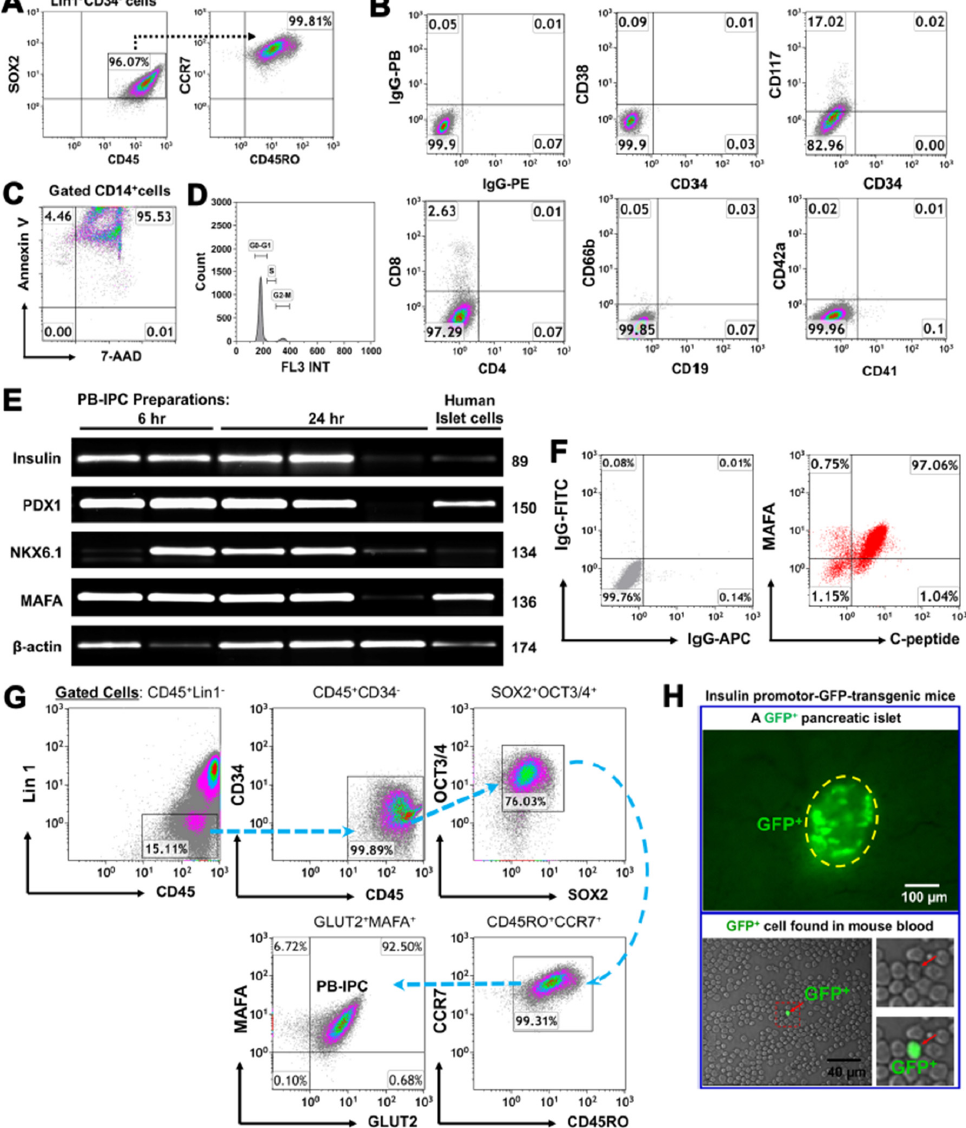
Figure 1. Characterization of peripheral blood-derived insulin-producing cells (PB-IPC) from adult peripheral blood with islet β -cell-related markers. ( A ) Characterization of PB-IPC. Peripheral blood-derived mononuclear cells (PBMC) were plated in Petri dishes in the presence of serum-free culture medium. After attachment overnight (12 hrs), PB-IPC were isolated by removing all floating cells and debris. The gated Lin1 - CD34 - cells express CD45, SOX2, CD45RO, and CCR7. Representative data from eight preparations. ( B ) Phenotype of PB-IPC, with low expression of CD117, but no expression of CD4, CD8, CD19, CD34, CD38, CD41, CD42a, and CD66b. Isotype-matched IgGs served as controls ( n = 8). ( C ) Apoptosis (Annexin V + ) and necrosis (7-AAD + ) of blood monocytes after 24-h culture in non-tissue culture-treated Petri dishes ( n =